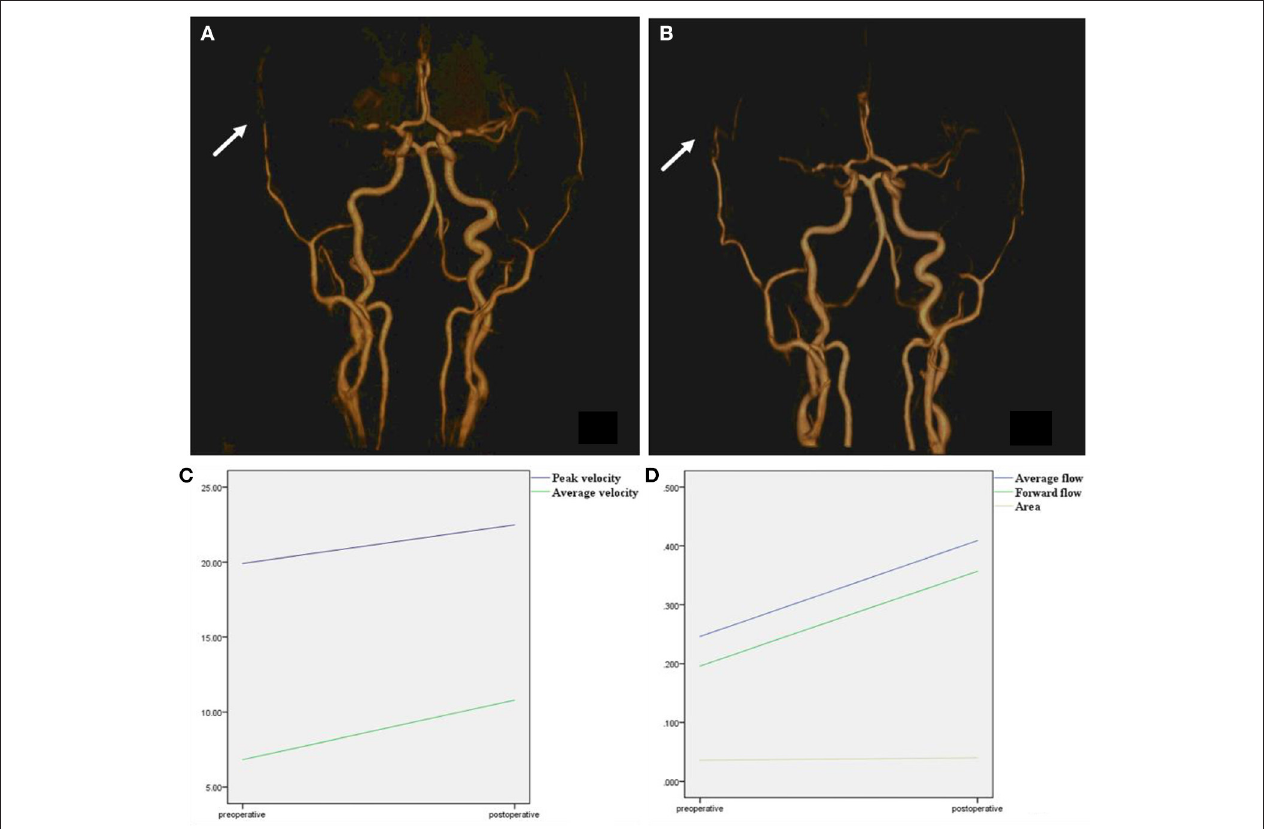
FIGURE 4 | Time-to-flight image before and after surgery. (A) TOF image before surgery, right superficial temporal artery was narrow before surgery (arrow). (B) TOF image after surgery, after combined surgery, the anastomoses vessel can be seen (arrow). The right superficial temporal artery was thickened compared with a preoperative image. (C) Peak velocity and average velocity of the right superficial temporal artery were significantly enlarged after surgery. (D) Average flow, forward flow, and area of the right superficial temporal artery were significantly enlarged after